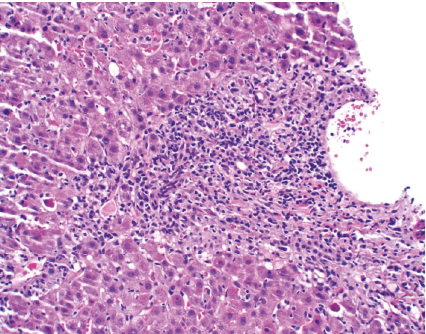
Figure 1: Interface hepatitis: portal tract with inflammatory infil- trate which extends past the limiting plate into the surrounding parenchyma (20x magnification).